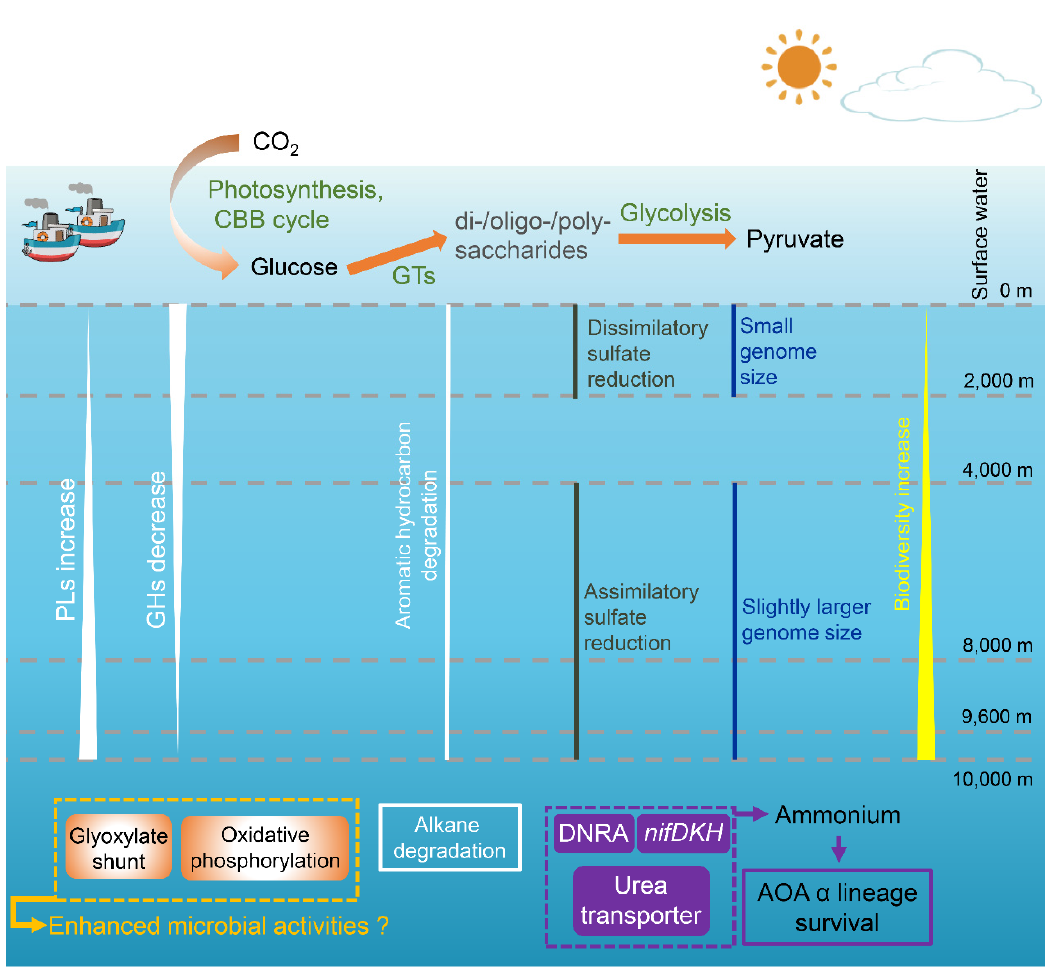
Figure 7. Selected processes throughout the water column. The biodiversity increased along the depths increased. The genome size of MAGs at ≥ 4000 m layers was slightly larger compared to those at 0–2000 m. Glycoside hydrolases (GHs) and Polysaccharide lyases (PLs) had inverse vertical variation patterns, showing a generally declining and increasing trend with depth,